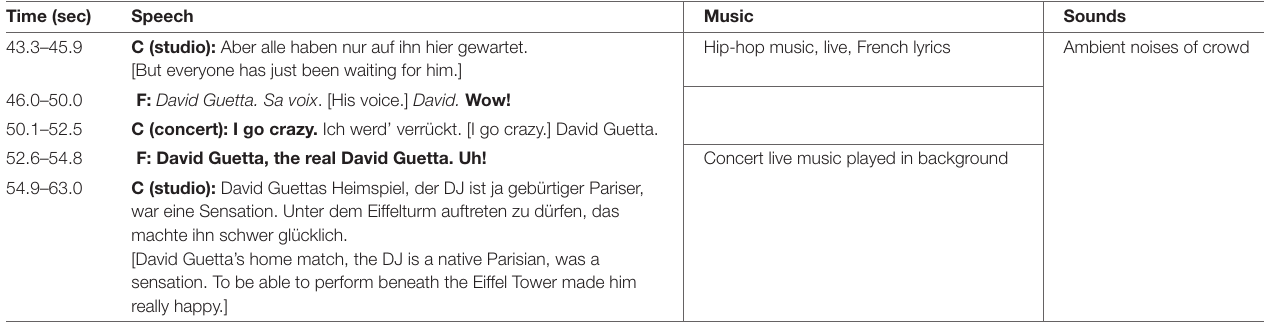
TABLE 1 | Foreign correspondent